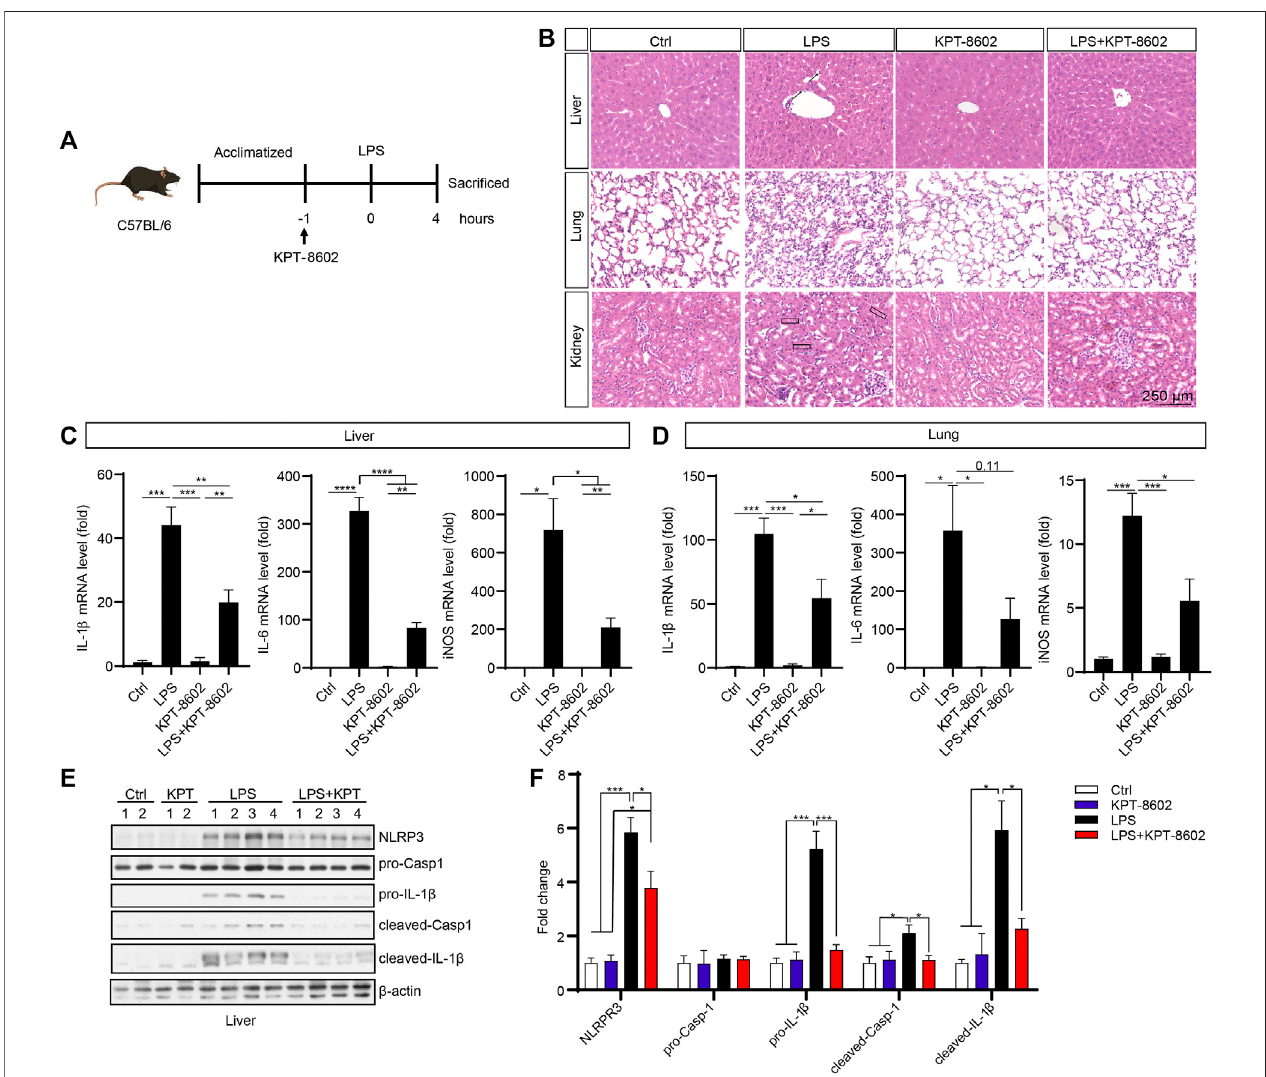
FIGURE 5 | KPT-8602 suppresses LPS-induced systemic in fl ammation. (A) C57BL/6 mice were given LPS (10 mg/kg) intraperitoneally after oral admiration of KPT-8602(5 mg/kg)orvehicle(5micepergroup). (B) Representativephotomicrographsofparaf fi n-embeddedsectionsoftheliver,lung,andkidneytissuesstainedwith H&E. Scale bars, 250 μ m for images, respectively. The expression levels of IL-1 β , IL-6, and iNOS in the liver (C) and lung (D) were detected by real-time PCR. The expression of NLRP3, pro-caspase-1, pro-IL-1 β , cleaved caspase-1, cleaved-IL-1 β , and β -actin in the liver was analyzed by Western blotting (E) , and the gray valuesoftheir bands were analyzed byusing ImageJ and werenormalized to β -actin (F) . (*indicates p < 0.05, ** indicates p < 0.01, ***indicates p < 0.001, **** indicates p < 0.0001 by one-way ANOVA).